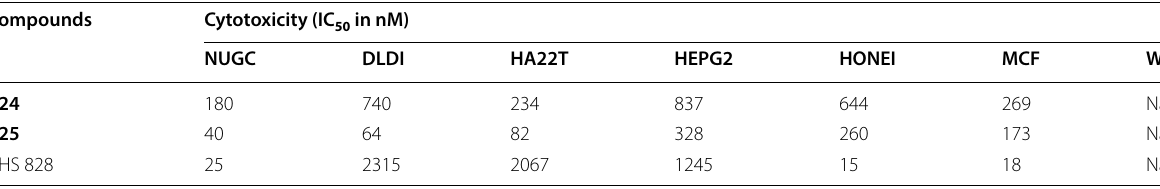
Table 24 Anticancer activity results of b24 and b25